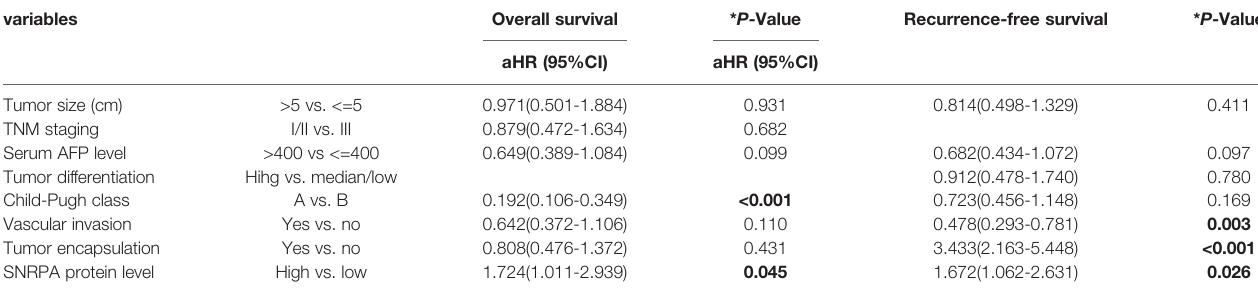
TABLE 3 | Multivariate Cox Regression analysis of overall survival and recurrence-free survival in 161 patients with hepatocellular carcinoma. variables